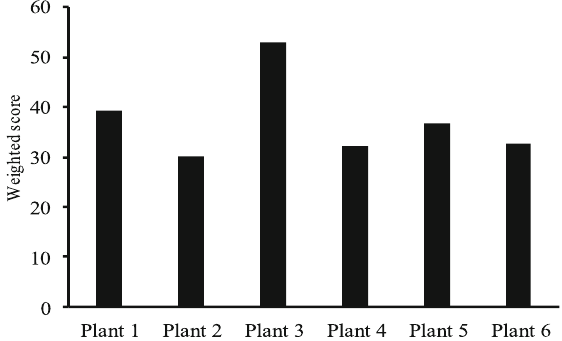
Fig. 7 The ranking results using the equal weight